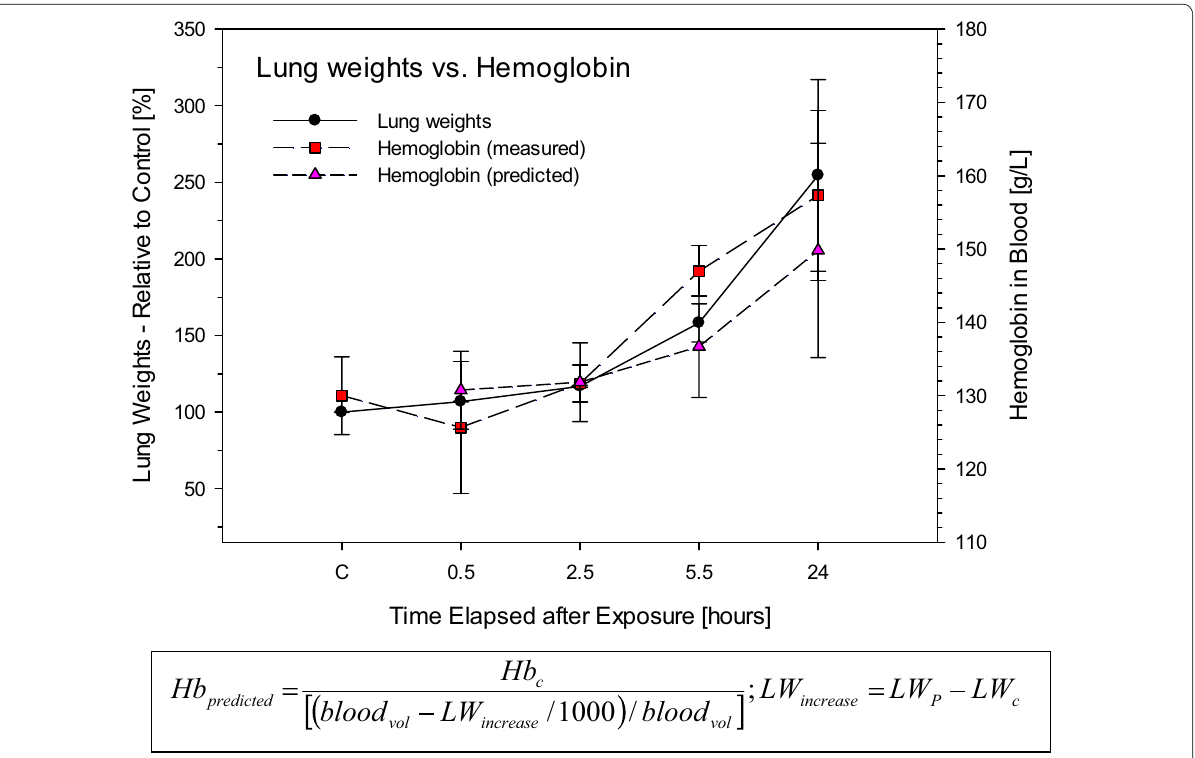
Fig. 4 Association of time-related increased lung weights (LW) and hemoglobin (Hb) in blood to analyze interrelationships that could explain fluid- shifts from blood into the lung. The degree of hemoconcentration was predicted based on the gain of lung weights (LW increase ) [mg] of phosgene- exposed rats relative to the lung weights (LW c ) and hemoglobin (Hb c ) [g/L] of pooled control rats. The blood volume was calculated using the following relationship: blood vol [mL] body weight [g] 6.4 [%] [142]. As an approximation, increased lung weights were considered equal to = × increased lung water content. Data points represent means SD (three rats per group and time ±